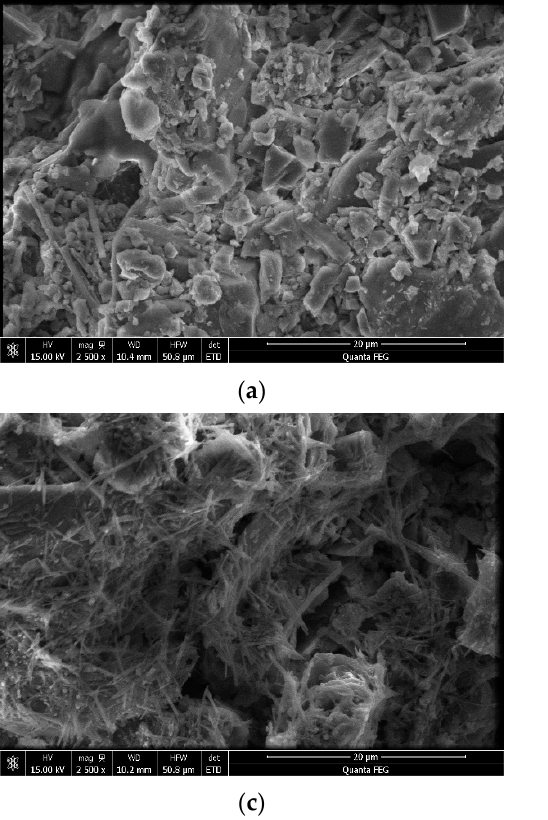
Figure 4. EDS image of PFWC-439/putty powder: spot 1 and spot 3 are the hydration products of the putty powder; spot 2, spot 4, spot 5 and spot 6 are MPM.